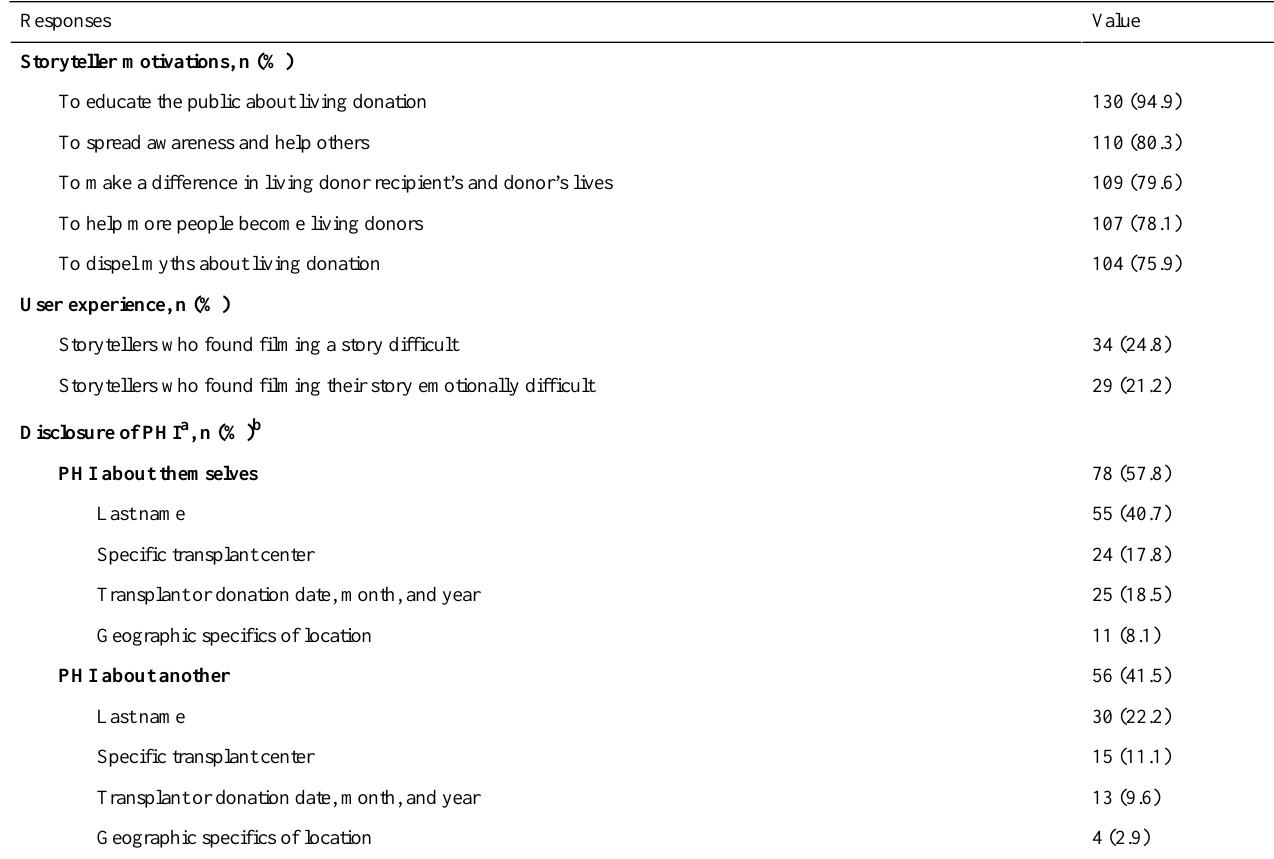
Table 2. Storyteller motivations, barriers, and disclosure of protected health information